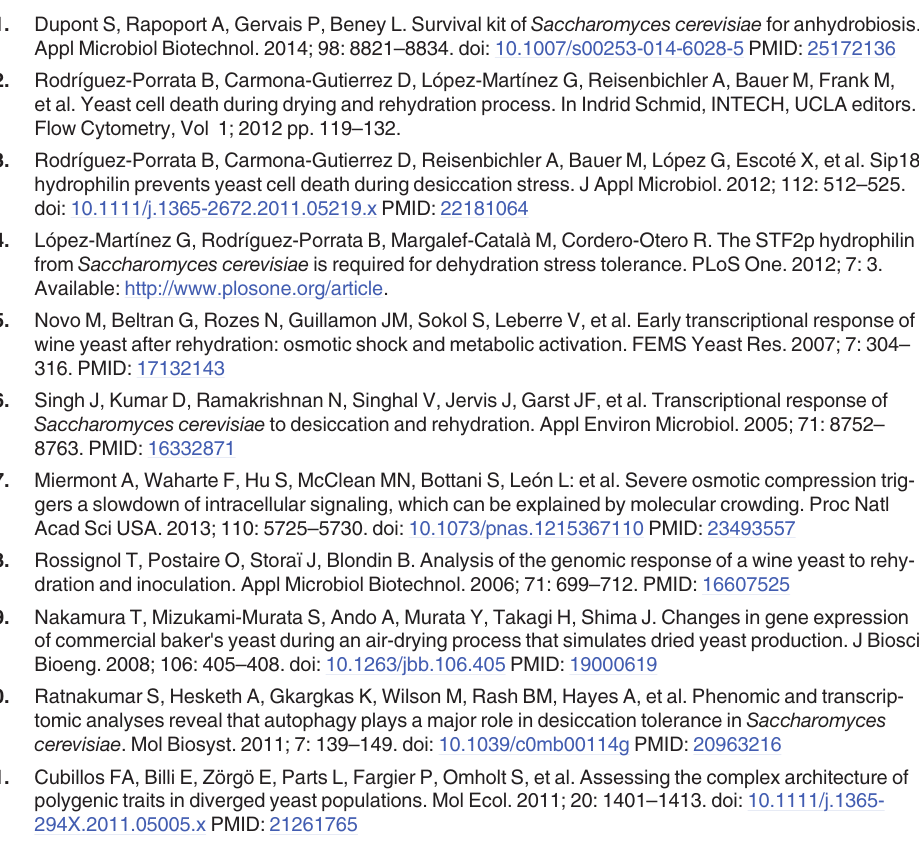
S1 Fig. Diagrams of strain generation. A) Production of F1 population [52]. B) Haploid strains were disrupted for the identified genes (e.g., ATG18 ) using URA3 and used to develop heterozygous diploid strains by reciprocal hemizygous crossover. S2 Fig. Quantitative real-time PCR analysis of gene expression before stress. Data represent mean relative expression ± SD (y axis, Log2 values) of each individual gene (show at the bot- tom) before dehydration of different strains. Genes ALG9 and TAF10 were simultaneously used as constitutive reference genes as determined by the geNorm algorithm [53]. Relative ex- pression was calculated using REST-MCS v2 software